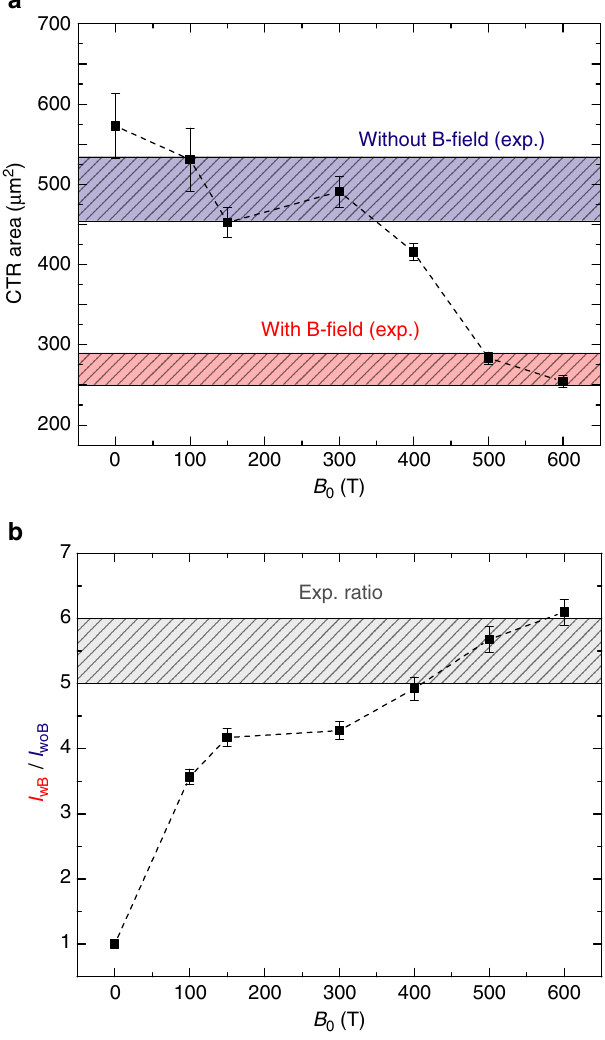
Fig. 5 In fl uence of the imposed B- fi eld strength on the coherent transition radiation. a Synthetic coherent transition radiation (CTR) pattern surface size (at full-width-at-half-maximum) evolution with B- fi eld strength at the coil center, B 0 (symbols). Red and blue bands identify the experimental CTR pattern sizes with and without applied B- fi eld. b Ratio of synthetic CTR yield with/without applied B- fi eld evolution with B 0 (symbols). The gray band identi fi es the experimental ratio. The images were analyzed as follows: Experimental images were fi rst subtracted from background noise, which produces the uncertainty on the experimental yield ratio. Synthetic images are convoluted by σ = 3 ± 1 μ m s.d. Gaussian functions, matching the spatial resolution of the experimental diagnostic. Error bars on synthetic yield ratios ensue from the considered Δ σ = ± 1 μ m. Both synthetic and experimental surface values are extracted by fi tting CTR patterns by bi- dimensional Gaussian functions. Uncertainties on fi t parameters arise from the pattern